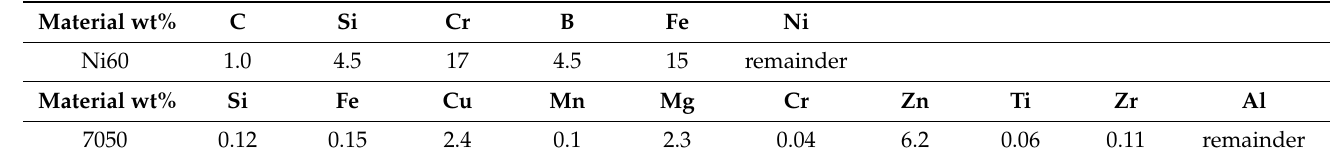
Table 2. Elemental composition of powder material and matrix material.